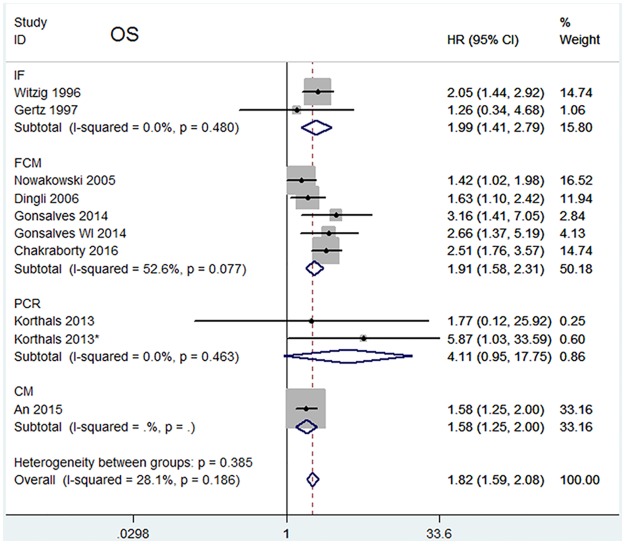
Forest plot of HRs and 95%CIs for OS.Subgroup analysis was according to different detection methods. The black boxes’ sizes are proportional to the study weight, with the lines indicating 95% confidence intervals (CIs). HR higher than 1 indicate that the presence of CPCs is associated with worse prognosis.